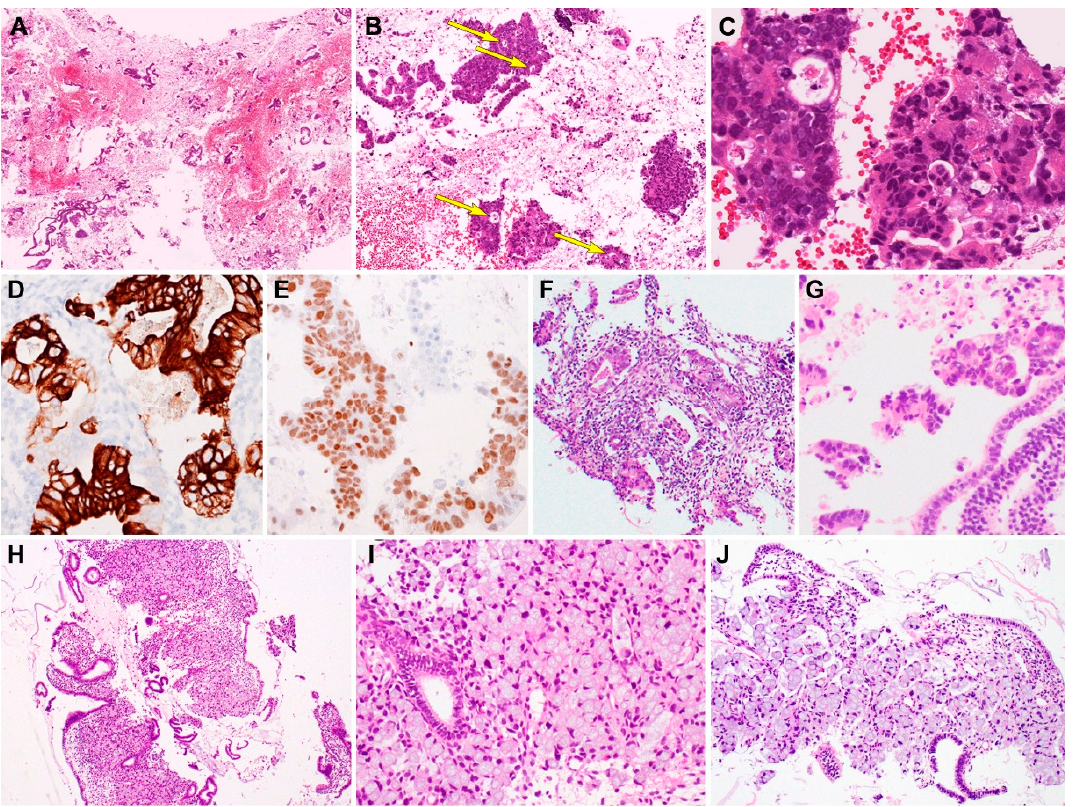
Figure 3. Histopathological findings and immunostaining results of metastatic gastrointestinal carcinoma. Metastatic colorectal adenocarcinoma (case 4). ( A ) Curetted specimen consists mainly of blood, fibrin, and necrotic debris admixed with tumor tissue fragments of variable size. ( B ) Irregular-shaped clusters of tumor cells exhibit solid and cribriform architecture with small glandular lumina (long yellow arrows). ( C ) Intraluminal eosinophilic material, necrotic debris, and severe nuclear pleomorphism of the glandular epithelium are morphologically consistent with colorectal adenocarcinoma. ( D ) Tumor cells are strongly positive for CK20. ( E ) Tumor cell nuclei also react uniformly with CDX2. Metastatic colorectal adenocarcinoma (case 5). ( F ) In a few foci, infiltrating tumor tissues are associated with small amount of stromal desmoplasia and artifactual clefts. ( G ) Fragmented epithelium possess larger, more hyperchromatic tumor cell nuclei, compared with those of endometrial strips (right lower corner). Metastatic gastric (case 6) and appendiceal (case 7) signet ring cell carcinoma. ( H ) Metastatic signet ring cell carcinoma from the stomach involving the endometrial stroma. ( I , J ) Medium-power magnification demonstrating aggregates of signet ring cells with typical morphological features of large collections of intracytoplasmic mucin compressing the nuclei towards the periphery of the cell. The entrapped endometrial glands possess small and bland nuclei. The uninvolved endometrial stroma display bland-appearing spindle cells (right lower corner). Original magnification: A , × 12.5; B , × 40; C : × 200; D : × 200; E , × 200; F , × 100; G , × 200; H , × 40; I , × 200; J , ×